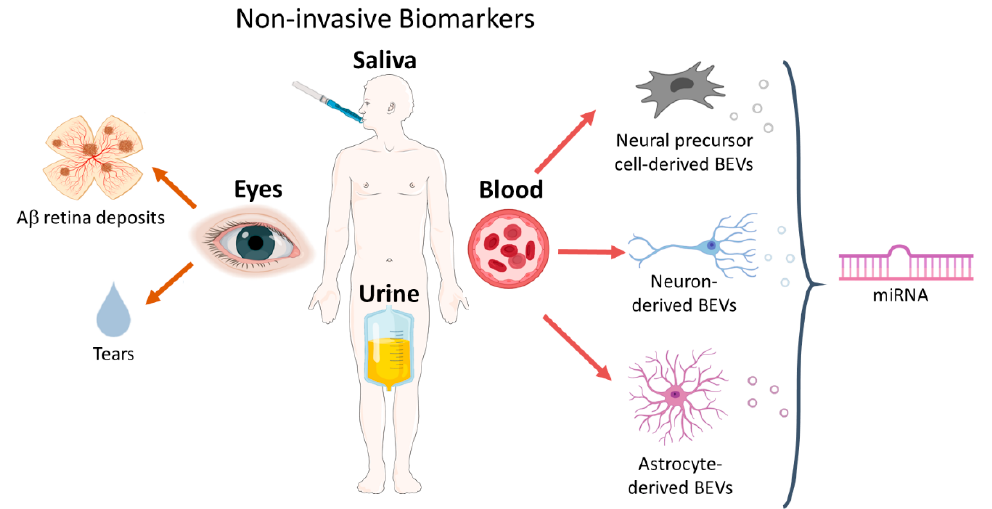
Figure 2. Schematic overview of noninvasive biomarkers: eyes, saliva, urine and blood. Besides fluid biomarkers (tears) that can be collected from the eyes, the promising advances in in vivo retinal imaging could provide an AD diagnosis tool in the near future. Blood-isolated brain secreted extracellular vesicles (BEVs) derive from three possible brain cell types: neural precursors, neurons and astrocytes. The content of this blood-isolated BEVs, mainly miRNAs, have been investigated as potential AD biomarker.